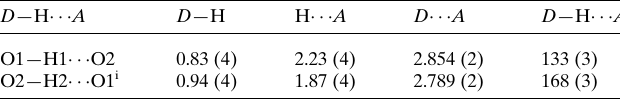
Table 2 Experimental